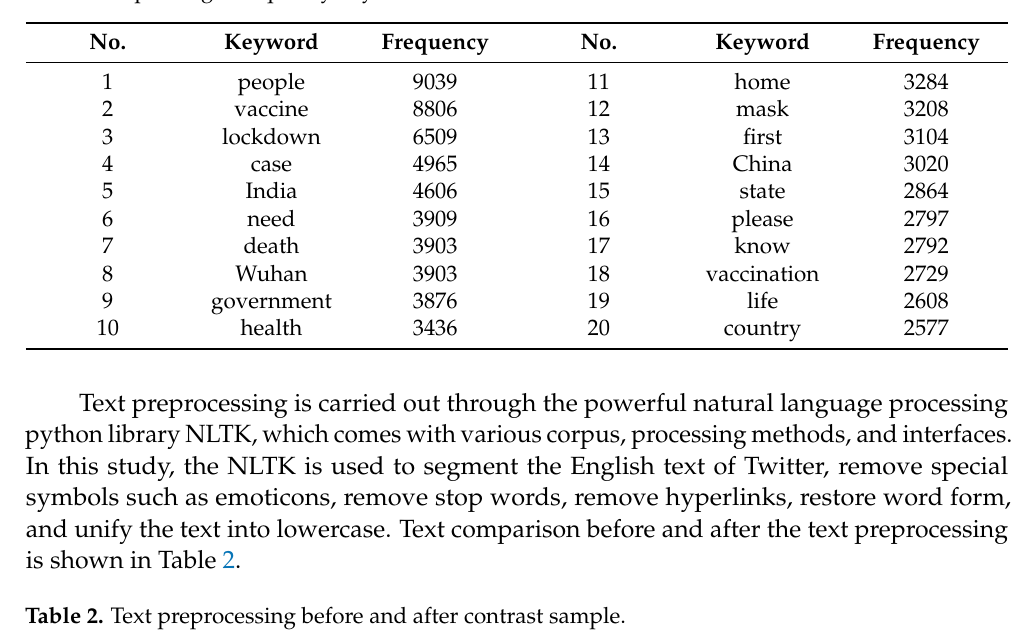
Table 1. Top 20 high-frequency keywords in tweets.